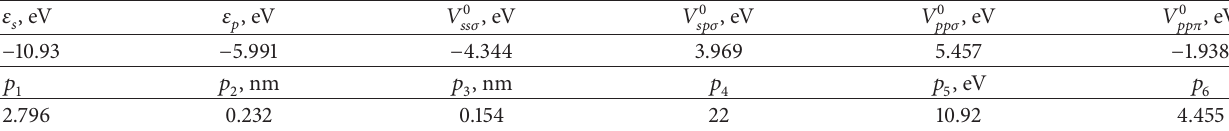
Table 1: Values of the parameters.